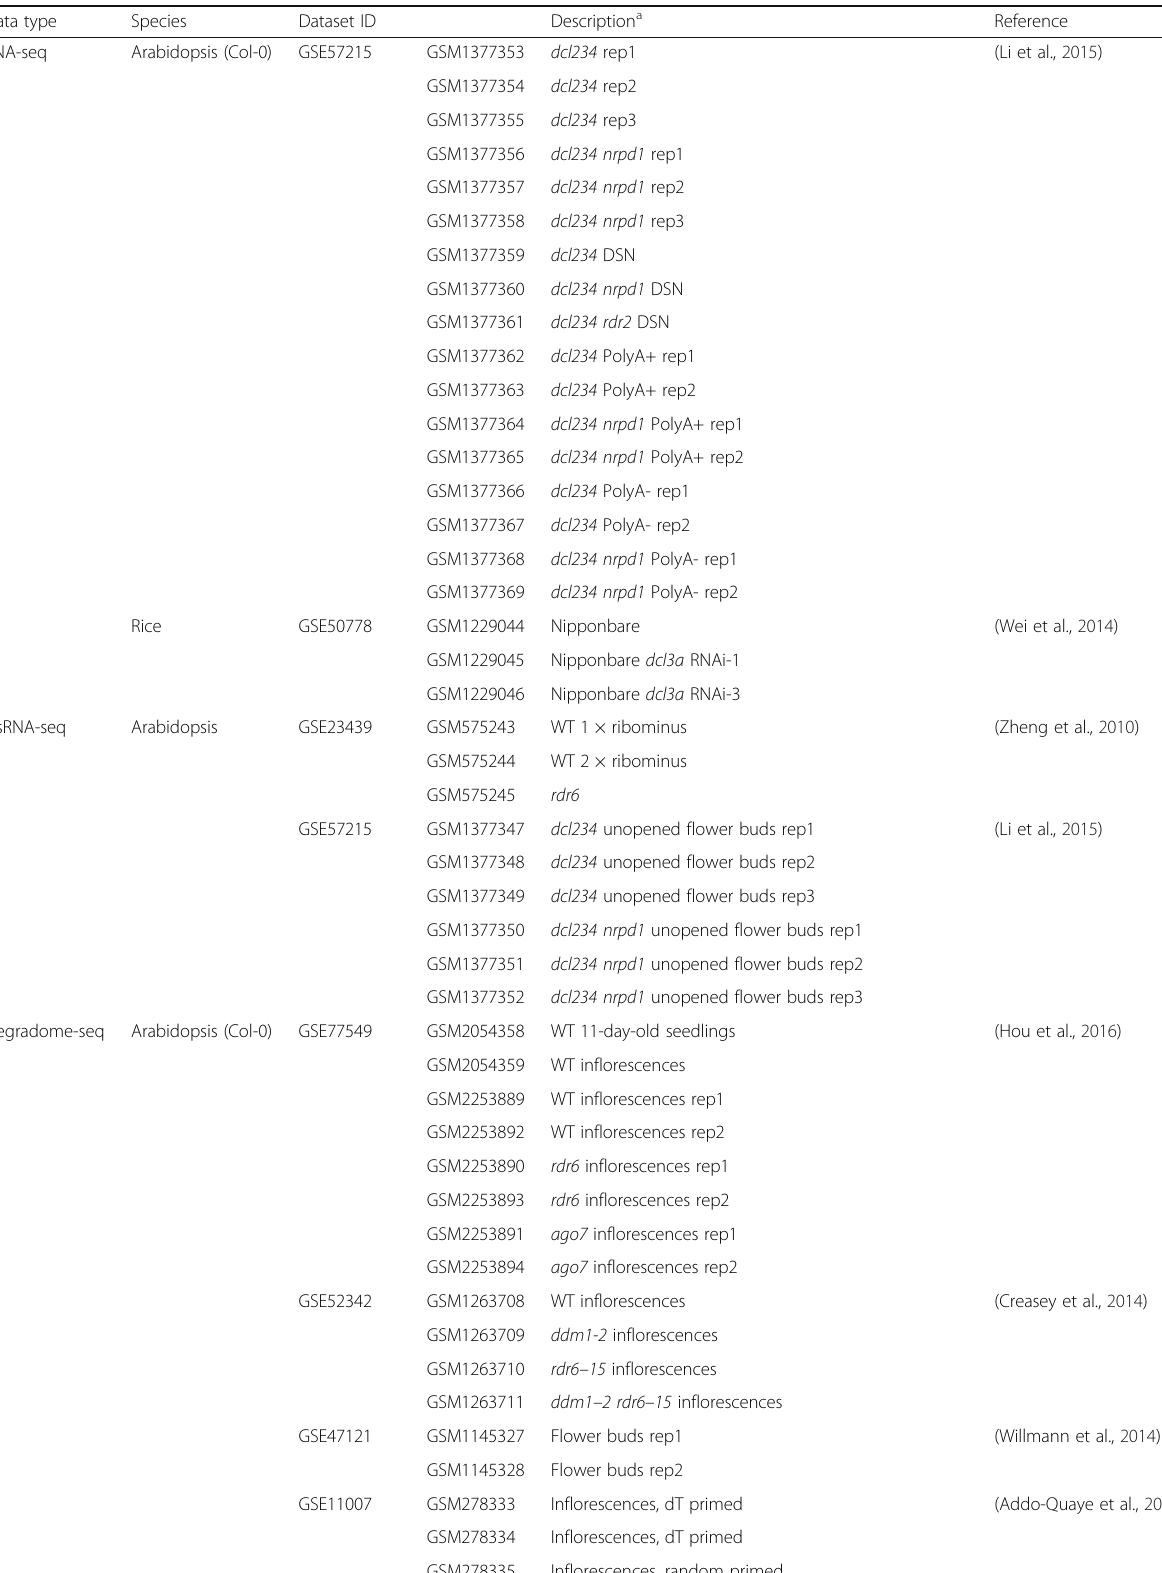
Table 3 List of sequencing data for plant small RNA